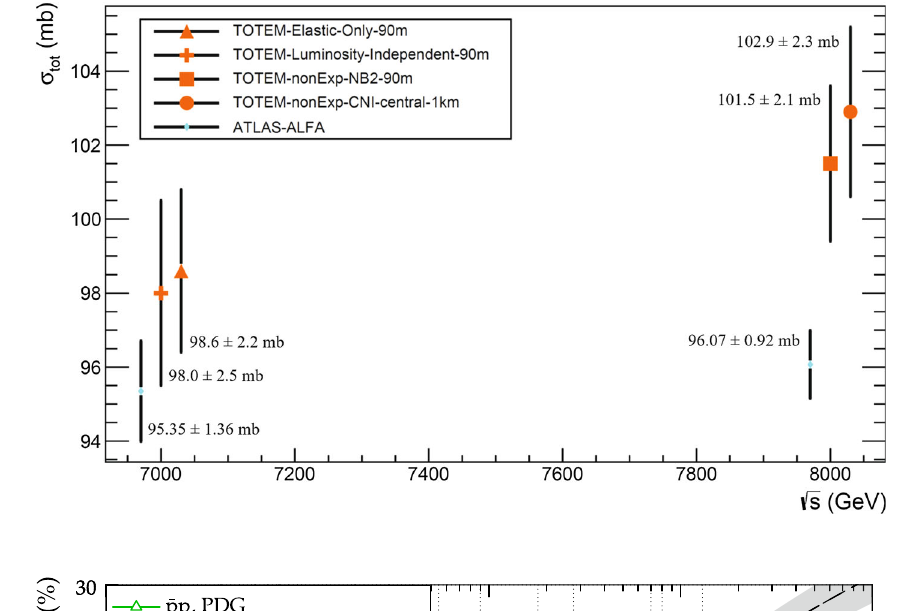
Fig. 6 The elastic to total cross section ratio for pp and p ¯ p collisions as a function of √ s